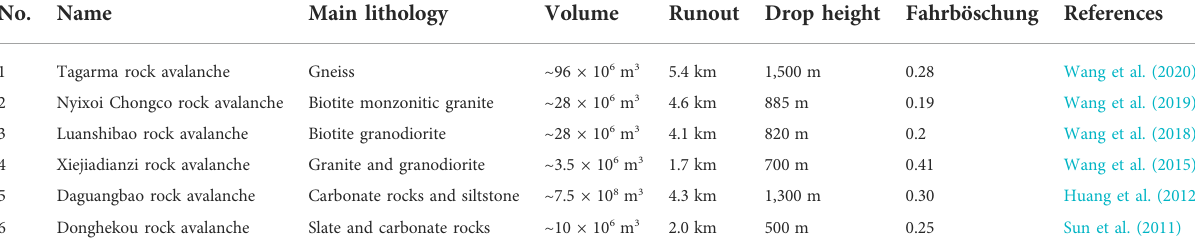
TABLE 1 Details of the studied rock